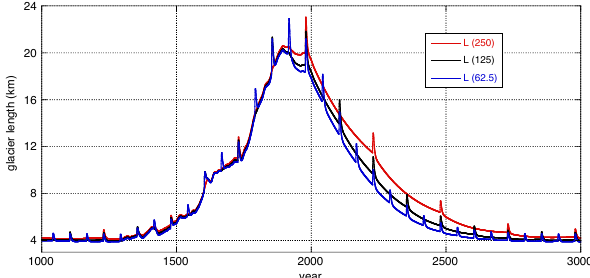
Figure 10. The effect of surges on the evolution of Abrahamsen- breen. The “reference” simulation is the same as in Fig. 8 (note that Fig. 10. The effect of surges on the evolution of Abrahamsenbreen. The ‘reference’ 3 this simulation has a 125-year surging simulation is the same as in Fig. 8 (note that this simulation has a 125 yr surging period). 4